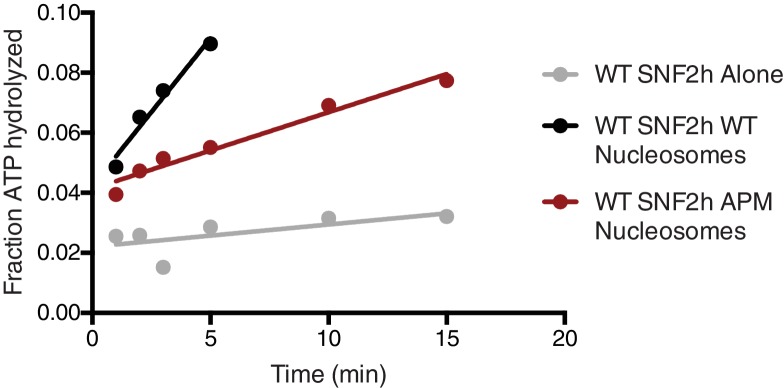
Representative ATPase assay fits.Saturating concentrations of nucleosomes (200 nM WT nucleosomes, 187 nM APM nucleosomes) were incubated with 12.5 nM enzyme and 7.5 µM ATP•Mg, and trace amounts of γ-P32 ATP. Reactions were analyzed by thin layer chromatography followed by radiography. Initial rates were determined by a linear fit to the first 10% of ATP hydrolyzed in the reaction.10.7554/eLife.35322.006Figure 1—figure supplement 2—source data 1.Values used to obtain plots.